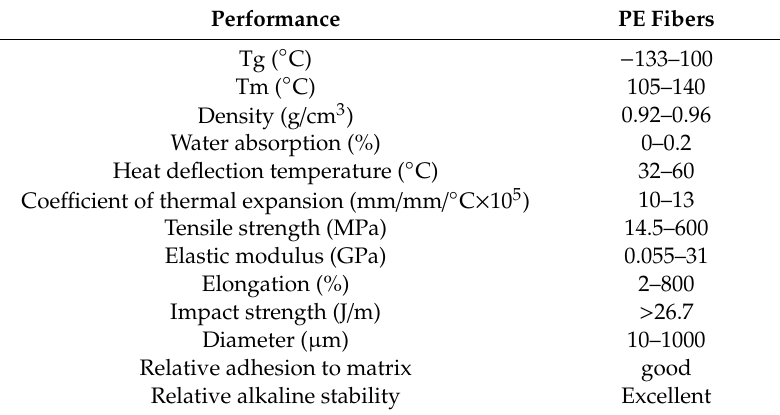
Table 1. The physical properties of polyethylene (PE) fibers